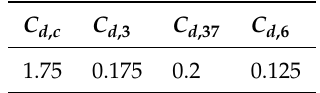
Table 2. Drag coefficients implemented in Equations (14) to (17).